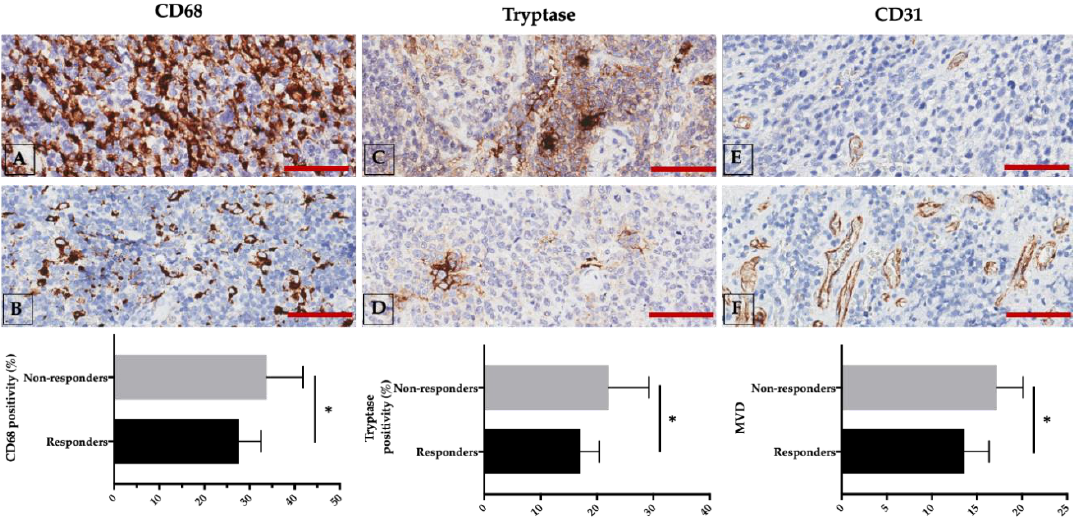
Figure 1. Non-responder (upper panels ( A , C , E ) and responder newly diagnosed diffuse large B-cell lymphoma (DLBCL) patients (middle panels ( B , D , F ) are characterized by different CD68, tryptase, and CD31 expression. Lower panels: respective comparison of non-responder and responder groups. Scale bar: 50 μm. * p < 0.05, assessed by Mann – Whitney test. Representative images from 29 untreated DLBCL patients are presented [112].